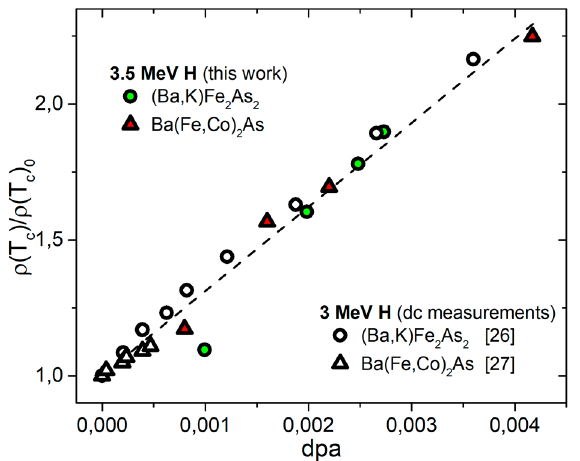
Figure 4. Resistivity (at T c ) increase as a function of the amount of introduced defects in terms of dpa for proton irradiated optimally doped Ba 1 − x K x Fe 2 As 2 and Ba( Fe 1 − x Co x ) 2 As 2 . Data for 3 MeV H irradiation (white symbols) are taken from Refs. 26,27 and obtained by low temperature irradiation and in-situ dc resistivity measurement.